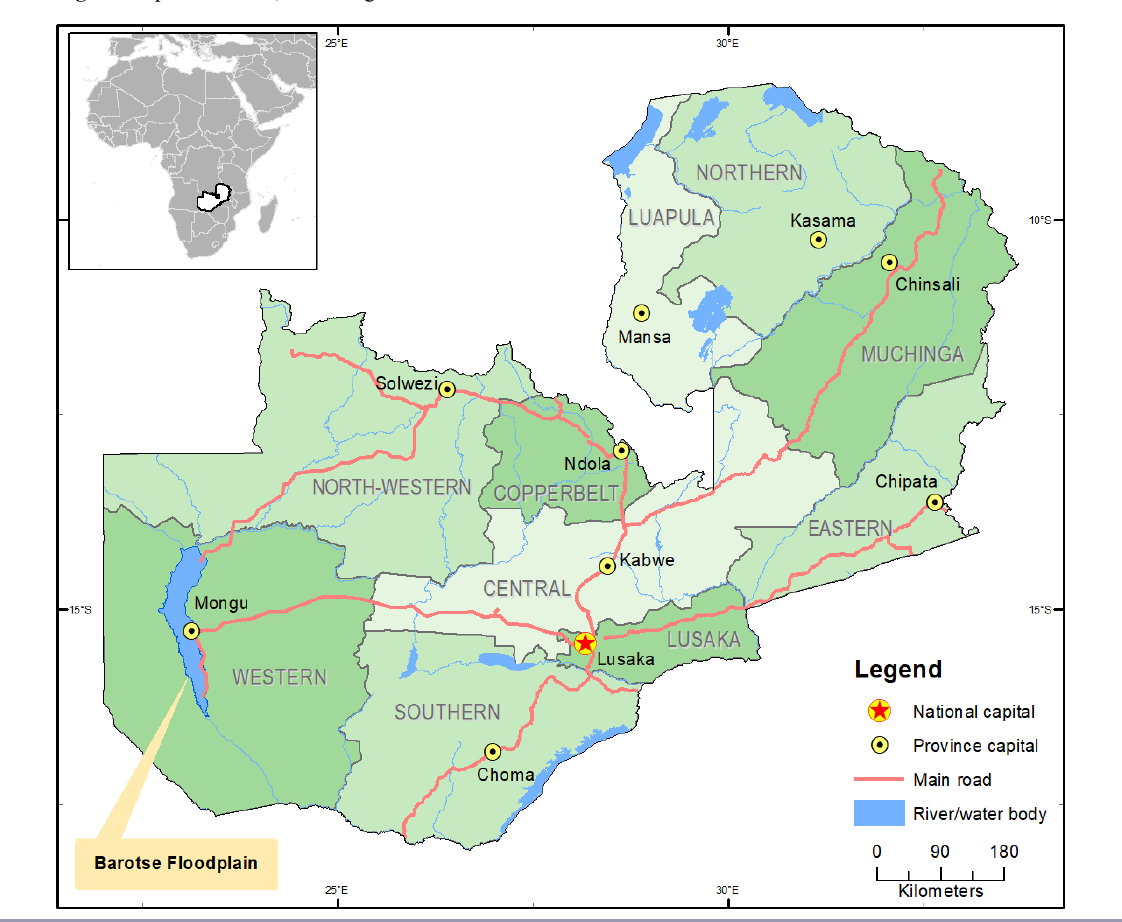
Fig. 1 . Map of Zambia, including main rivers/water